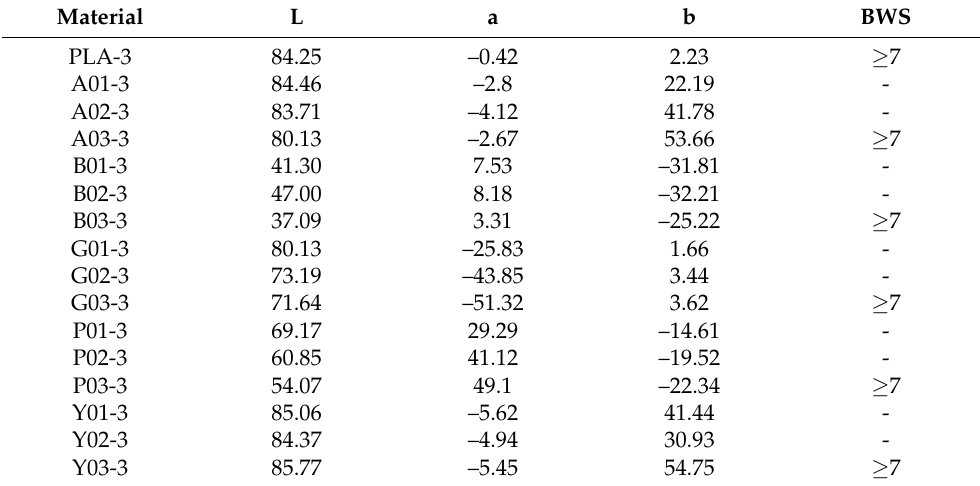
Table 5. CIE L*a*b color values and blue wool scale (BWS) of PLA and dyed